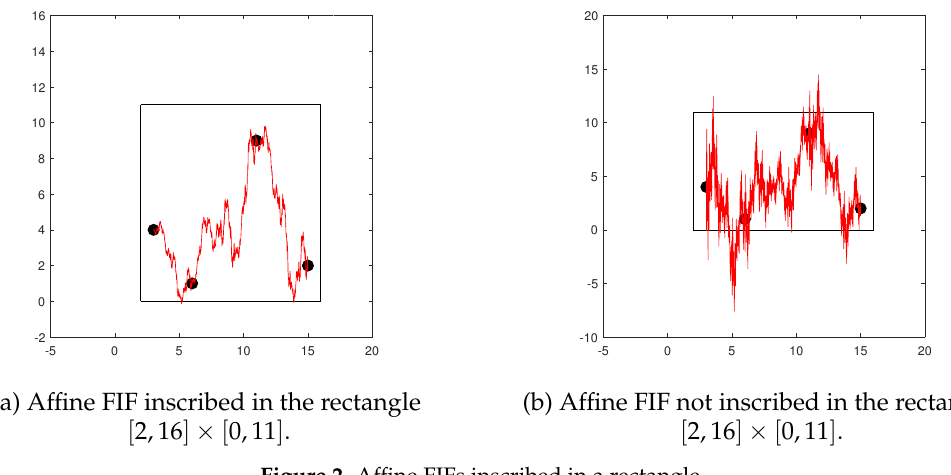
Figure 2. Affine FIFs inscribed in a